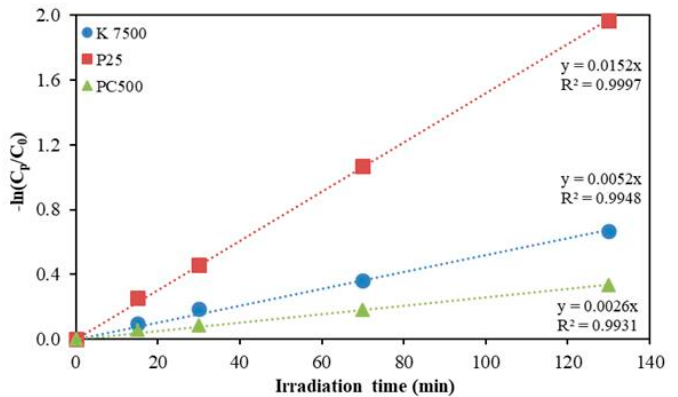
Figure 1. Degradation kinetics for clofibric acid (initial concentration 30 mg/L) with different TiO 2 commercial catalysts (1 g/L), UV ‐ A irradiation (9.52 mW/cm 2 ), natural solution pH, room temperature.